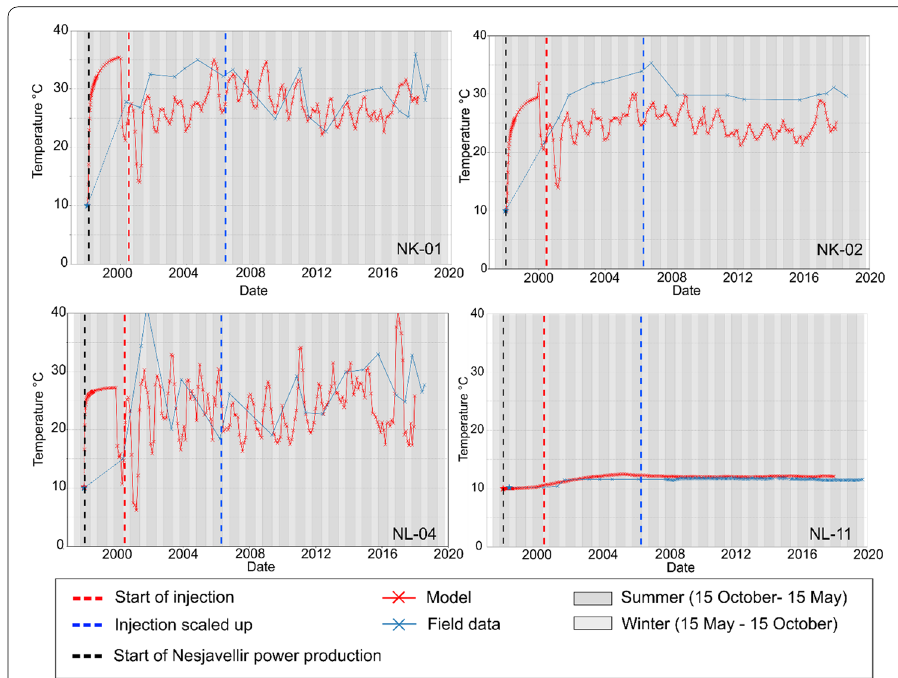
Fig. 8 Evolution of temperature from 1998 to 2018 at the near‑surface (< 10 m groundwater depth) in NK‑01, NK‑02, NL‑04 and NL‑11. Field data in blue and model results in